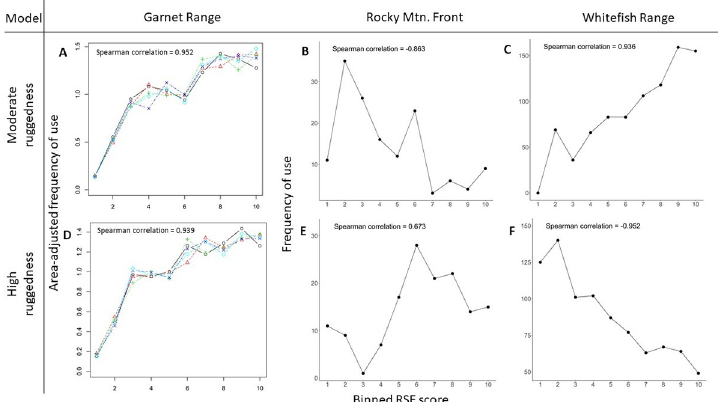
Fig 6. External cross validation of mountain lion resource selection functions. Rows correspond with different resource selection functions (RSFs) developed for mountain lions using GPS collar data from the Garnet Range, MT, USA, and columns indicate the study area in which data to test each RSF originated. Frames ‘A’ and ‘D’ show results from internal k-folds cross validation, plotting area-adjusted frequency of use by mountain lions (y axis) per RSF bin (x axis) from fixed-effect logistic regression models developed with GPS collar data from mountain lions. Each line in these plots represents 1 out of 5 folds of data used to cross-validate RSF predictions. Mean Spearman correlations were calculated between each RSF bin rank and area-adjusted frequency of use in each bin. Frames ‘B’, ‘C’, ‘E’ and ‘F’ show results from external cross-validation with raw frequency of use (y axis) per equal-area binned RSF deciles (x axis). Spearman correlations were calculated between each RSF bin rank and frequency of use in each